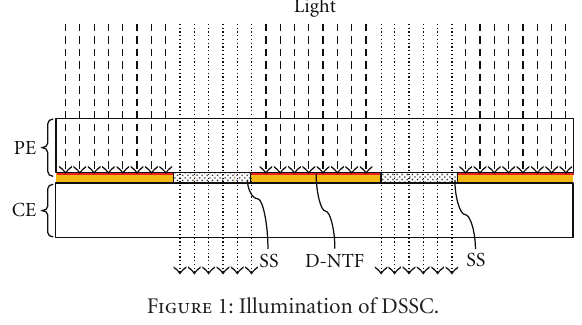
Figure 3: Illustration of EL in directing light toward D-NTF.